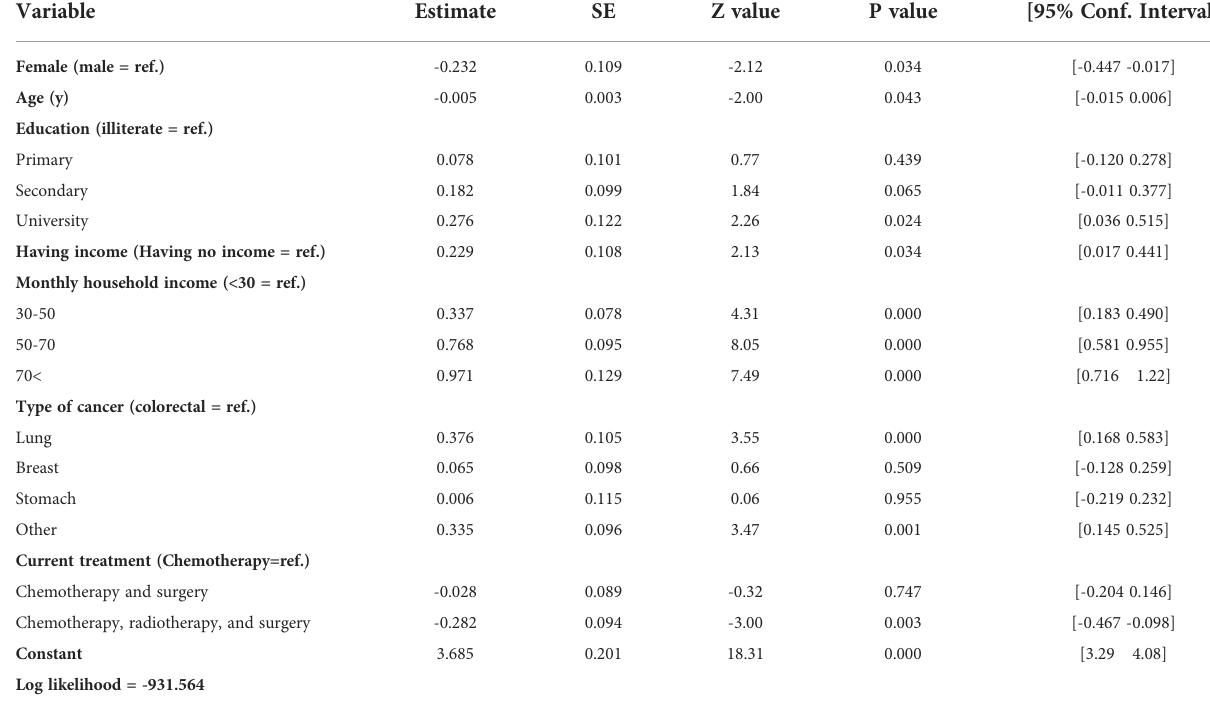
TABLE 3 Results of Weibull regression analysis for WTP per QALY ( n = 565). Variable Estimate SE Z value P value [95% Conf. Interval] Female (male =